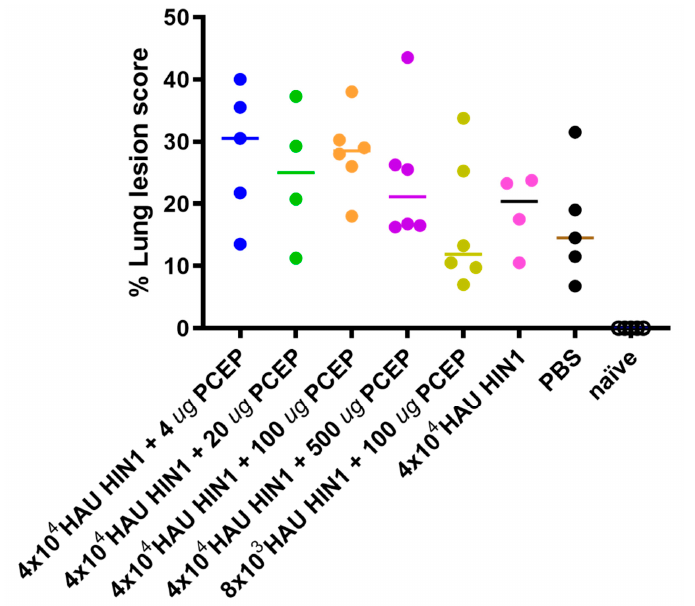
Figure 5. Lesion scores in lungs of vaccinated and challenged animals. Pigs ( n = 6) were immunized then boosted at day 21 via intradermal routes with 4 × 10 4 or 8 × 10 3 HAU H1N1 plus 0–500 μ g PCEP adjuvant or PBS as indicated. Naïve animals were neither immunized, nor challenged. The challenge dose was 8 × 10 5 PFU virulent H3N2 SIV via the intratracheal route on day 35 and all animals were killed 6 days after challenge. The lung lesion scores were assessed (as indicated in the methods) up to 6-days post challenge. Each data point indicates an individual animal and the horizontal bar represents the median. The colors of each data point are coordinated with the group colors from Figures 1–3.